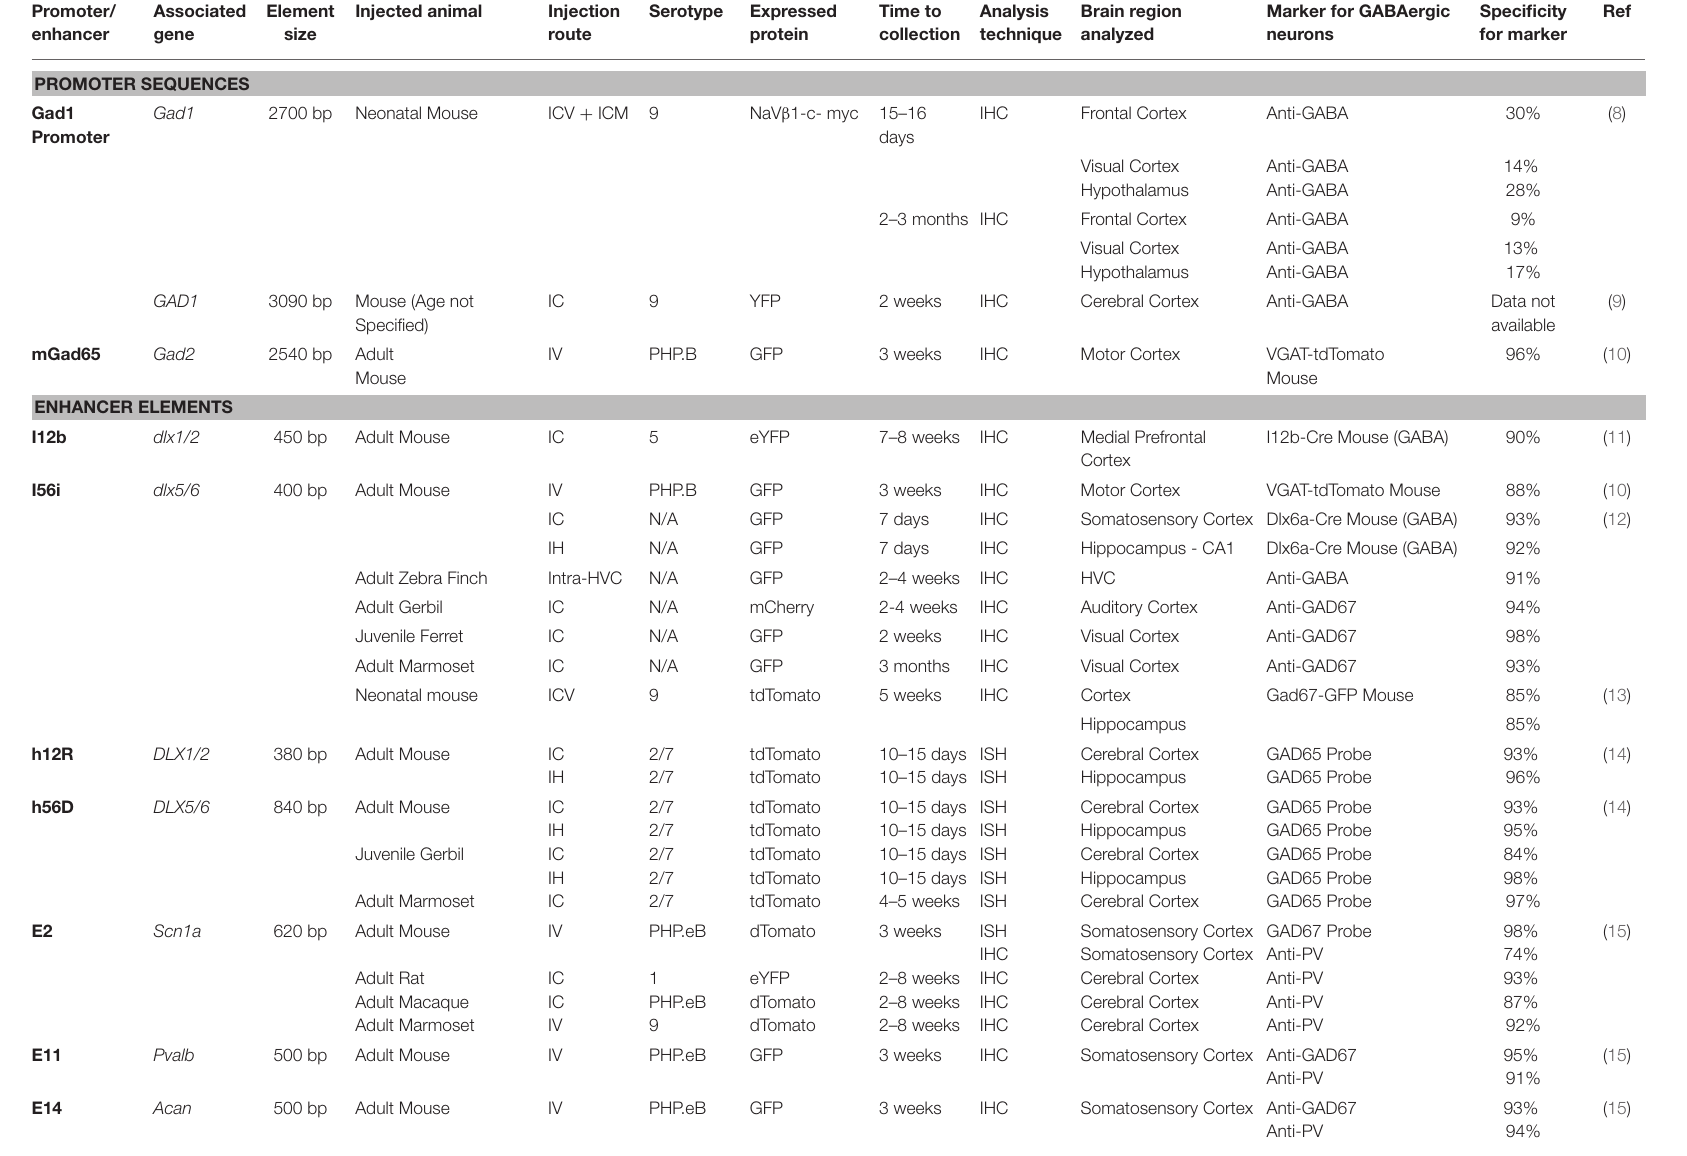
TABLE 1 | GABAergic neuron-selective regulatory elements tested with rAAVs. Promoter/